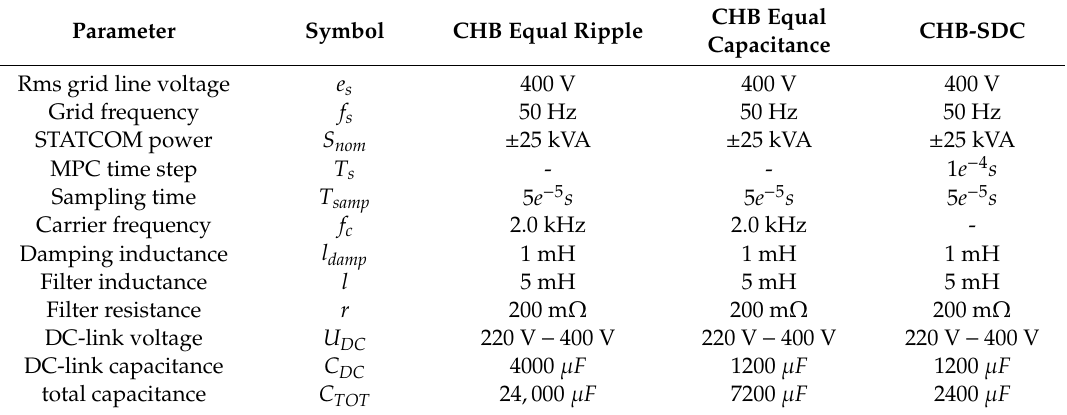
Table 2. System parameter